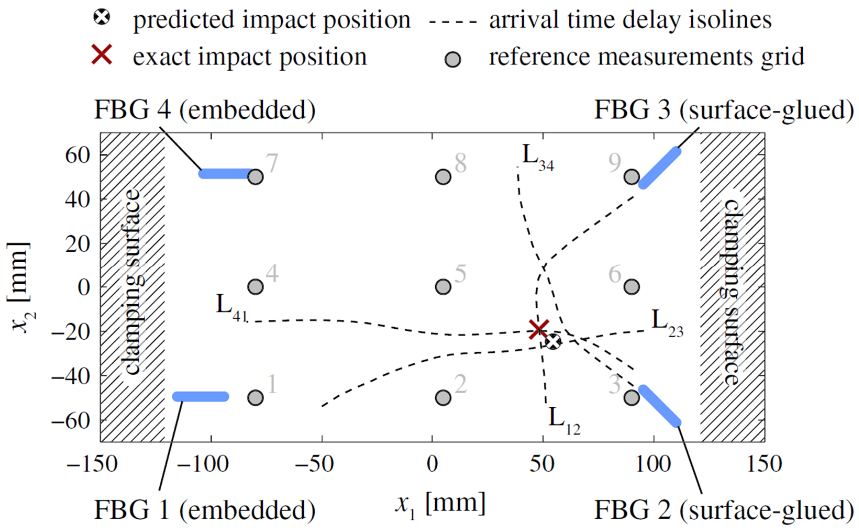
Figure 11. The isolines of equal arrival time delays and predicted impact location [104].